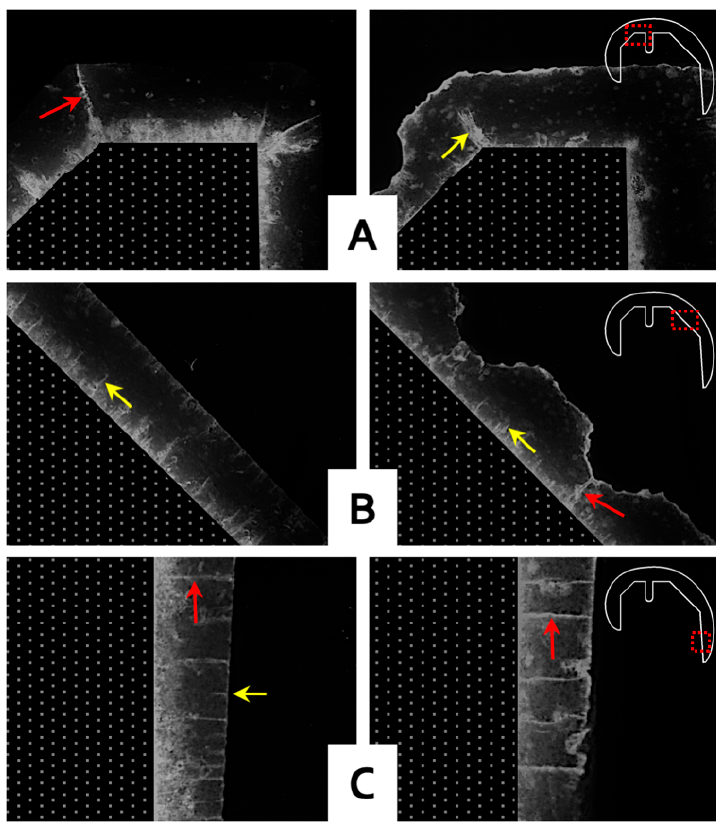
Figure 6. Representative images of CoCr (left) and PEEK (right) reconstructions after 10 MC, showing dye penetration in cement mantle cracks at three locations ( A – C ) around the femoral component as indicated by the red squares in the detail-figures. The red arrows indicate full-thickness cracks in the PMMA cement, the yellow arrows incomplete cracks. The reduced cement mantle thickness, caused by the ridges in the PEEK surface, is visible in ( B ) (right). Materials 2020 , 13 , x FOR PEER REVIEW